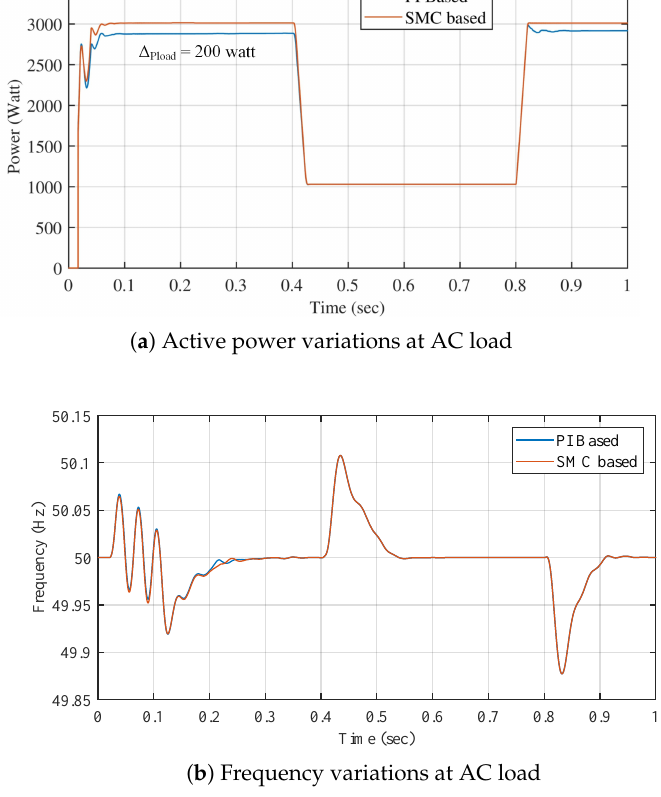
Figure 12. Case 5: Dynamical load